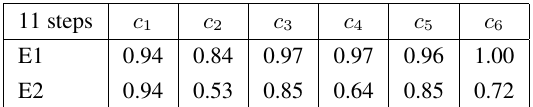
Table 7. Classification accuracy resolved by crop type based on 11 time steps for E1 and E2.